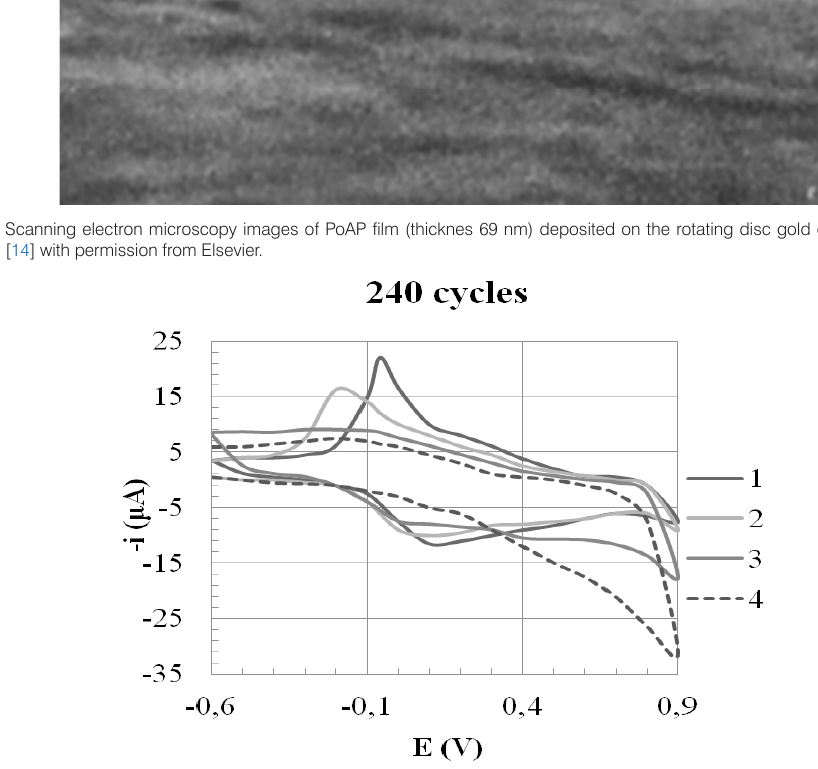
Figure 5. Effect of pH on the electrochemical behavior of PoAP on a GCE electrode. PoAP film deposited on GCE after polymerization of 1×10 -3 mol L -1 oAP in 1 mol L -1 HClO (Scan rate 100 mV s -1 ) Polymerization completed after 240 cycles. (1) pH=1.12, (2) 4